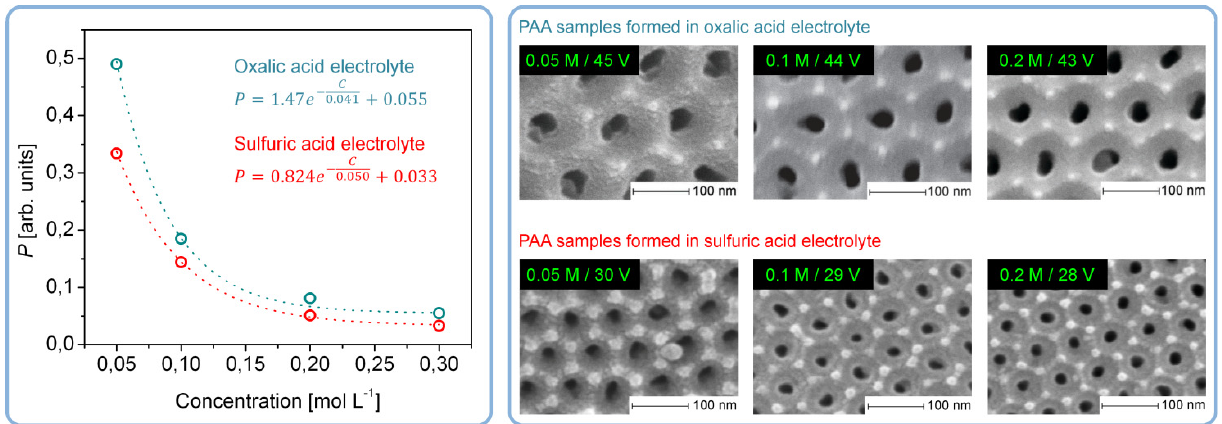
Figure 25. Left: exponential decrease in the critical values of the criteria P with increasing concentrations of H 2 C 2 O 4 and H 2 SO 4 anodizing electrolytes. Right: SEM micrographs of PAA layers obtained from both investigated types of electrolytes under the optimized anodizing conditions corresponding to the P values from the plot on the left ( P and ∆ U are related via Equation (4)). Adapted with permissions from [65,68]. Copyright 2016 The Royal Society of Chemistry and American Chemical